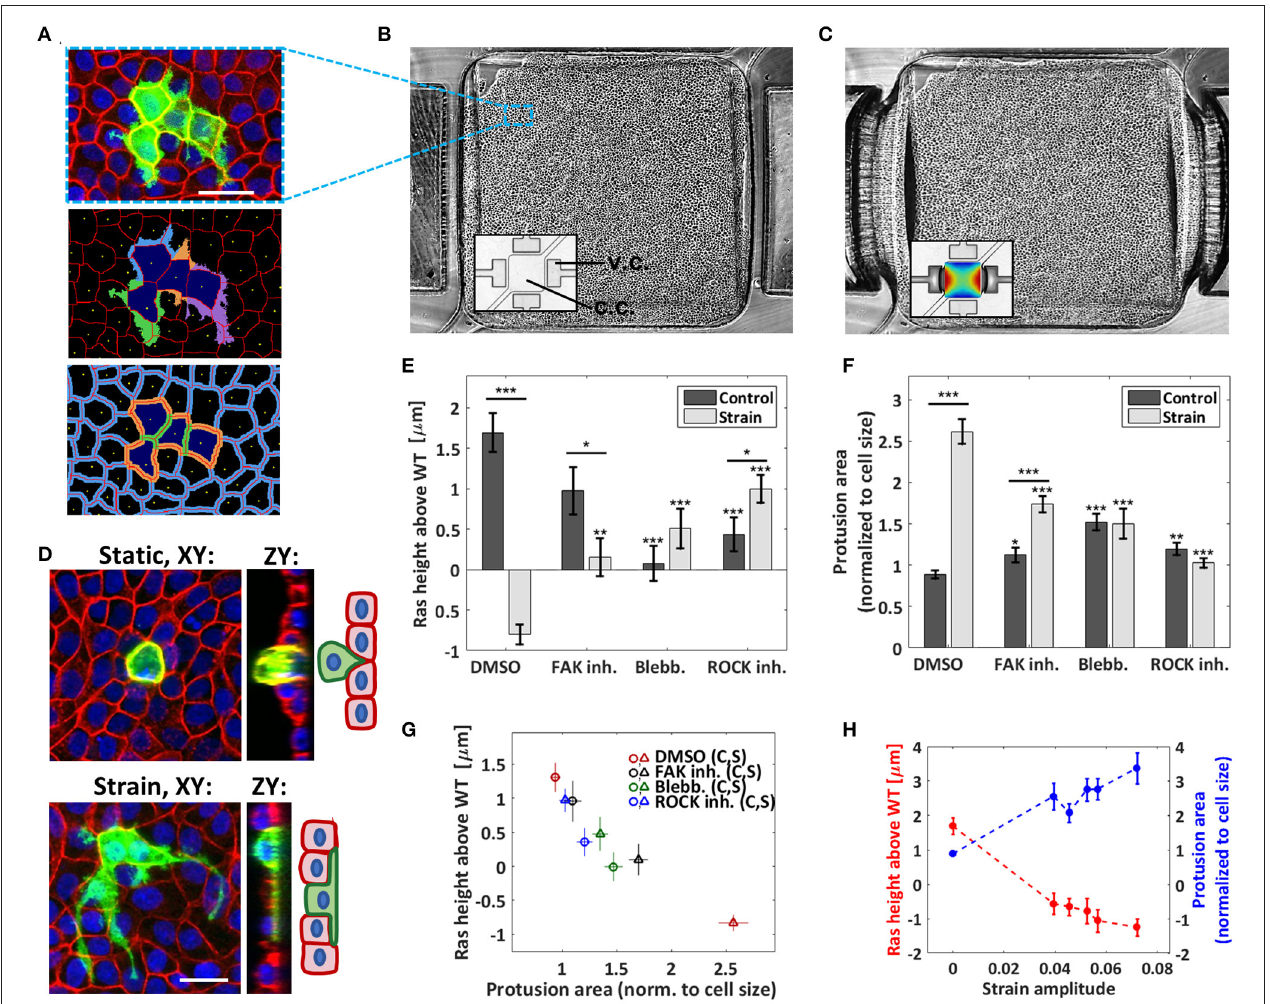
FIGURE 1 | Cyclic stretching increases protrusion formation and hinders apical extrusion. (A) Top: confocal image of the MDCK co-culture (Ras V12 and WT cells, static condition) with GFP-Ras V12 cells in green, actin in red, and nuclei in blue. Scale bar is 35 µ m. Middle and bottom: image analysis output showing the nucleus centers (yellow), the cellular contours (red), the Ras V12 cell bodies (dark blue), associated protrusions (middle) and the junctional regions (bottom: Ras V12 -Ras V12 in green, Ras V12 -WT in orange, and WT-WT in blue). (B,C) Monolayer grown in a PDMS pneumatic-based microfluidic stretcher in its relaxed (B) and stretched (C) states (phase contrast mode). The insets (bright field mode) show the empty device with the strain map superimposed in the stretched case (dark blue: 3%, dark red: 9%). The vacuum and cell chambers are identified as v.c. and c.c., respectively. The cell chamber width is 1.6mm. (D) Confocal images of GFP-Ras V12 transformed cells in WT monolayers 24h after tetracycline addition followed by F-actin (red) and nuclei (blue) staining. Scale bar is 25 µ m. Top: representative example of extruding Ras V12 cell obtained in a static control. Bottom: representative example of Ras V12 cell forming large protrusions obtained in a stretched experiment. (E) Average height difference between the Ras V12 and WT cells for the static controls and stretched experiments. (F) Average protrusion area relative to the cell body (i.e., excluding the protrusions) for the static controls and the stretched experiments. The drug-free case (DMSO) and three drugs were tested: FAK inhibitor, blebbistatin, and ROCK inhibitor. Data are mean ± s.e.m. *** P < 0.0001, ** P < 0.005, * P < 0.05. Stars above the individual bars relate to the corresponding DMSO condition. Stars above the horizontal lines refer to the significance between the control and strain data. From left to right in (E,F) : n = 234, 188, 78, 139, 268, 233, 237, and 334 cells each from 3 to 4 independent experiments. (G) Correlation between the average Ras V12 cell height and the average protrusion area for the 8 conditions presented in (E,F) . (H) Average Ras V12 cell height (red) and average protrusion area (blue) as a function of the strain amplitude, for the DMSO condition. The zero-strain points correspond to the average of the control data, and the non-zero strain points were obtained by binning the data of the stretched experiments into five bins each containing an equal (37 or 38) number of